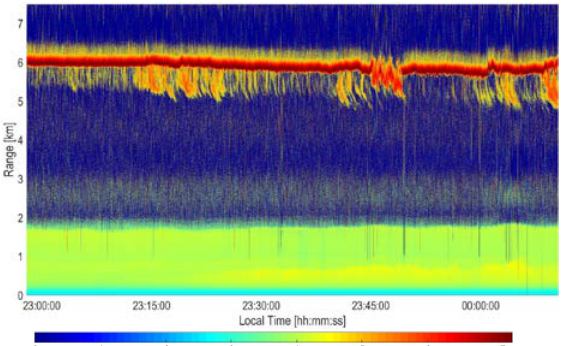
Figure 6. False color diagram for zoom-in near–field boundary layer structure at 2- µ m. Colors represent range corrected signal